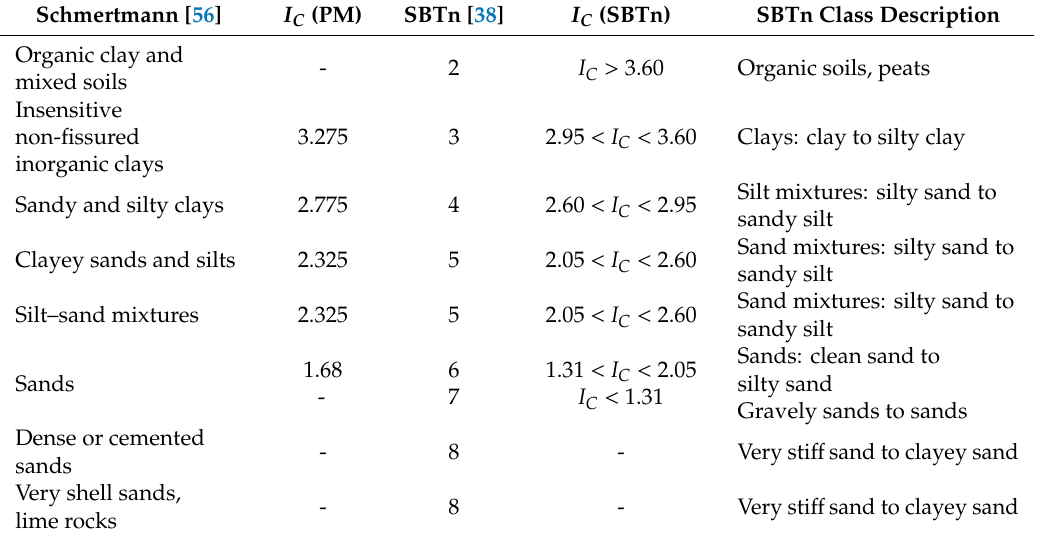
Table 5. Correspondence between Schmertmann [56] and Robertson [38] classification systems (classes 1 and 9 of the Robertson approach were not